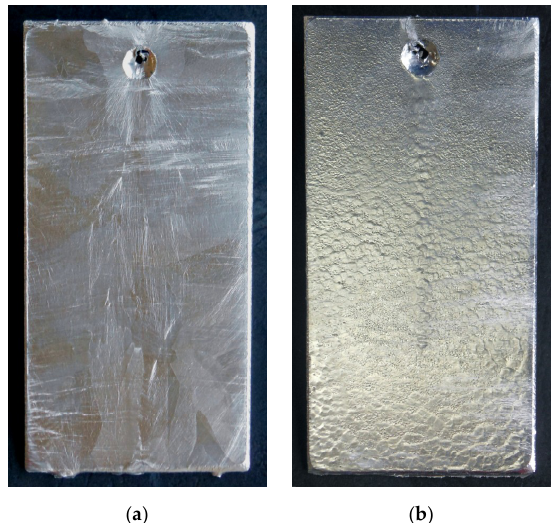
Figure 1. The view of the surface of coatings produced in the Zn-AlNiBi ( a ) and “pure” zinc bath ( b ) [17] before the research.